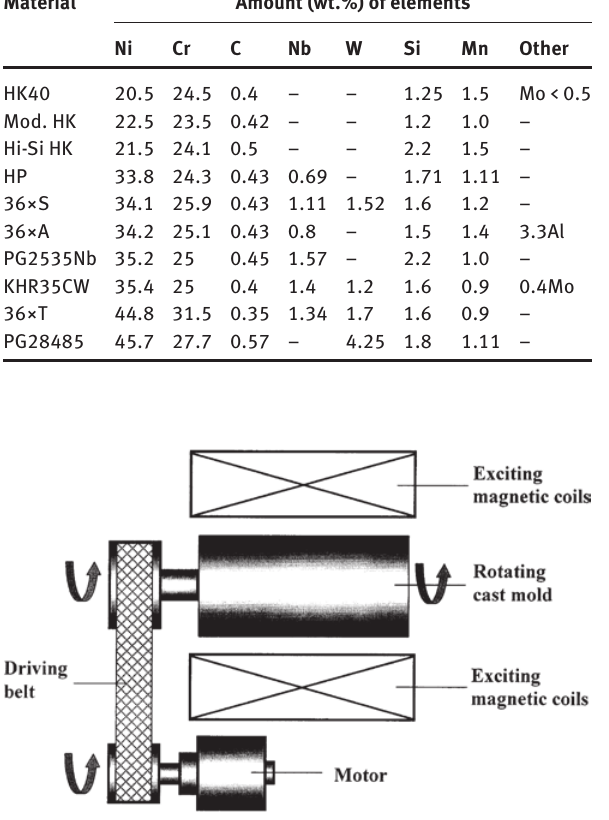
Fig. 1: Schematic diagram of the electromagnetic centrifugal casting equipment [12].